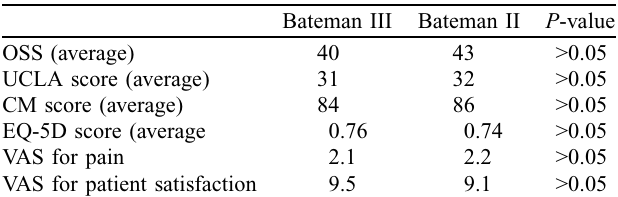
Table 7. Comparison between Bateman III and II shoulder scores 24 months post-operative.